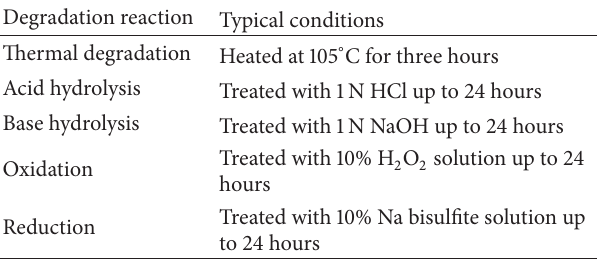
Table 1: Types of degradation reactions and